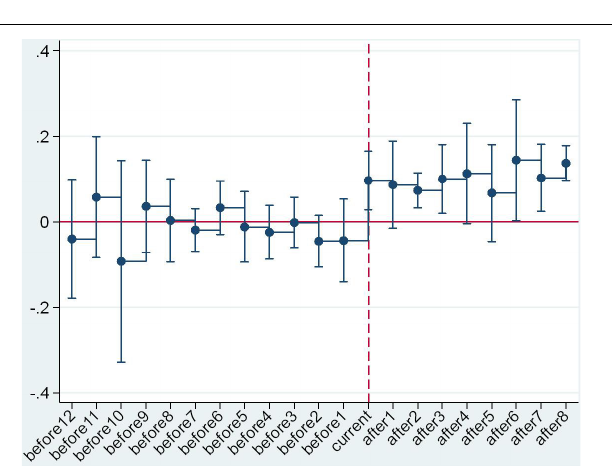
FIGURE 4 | Parallel trend test in the central region.